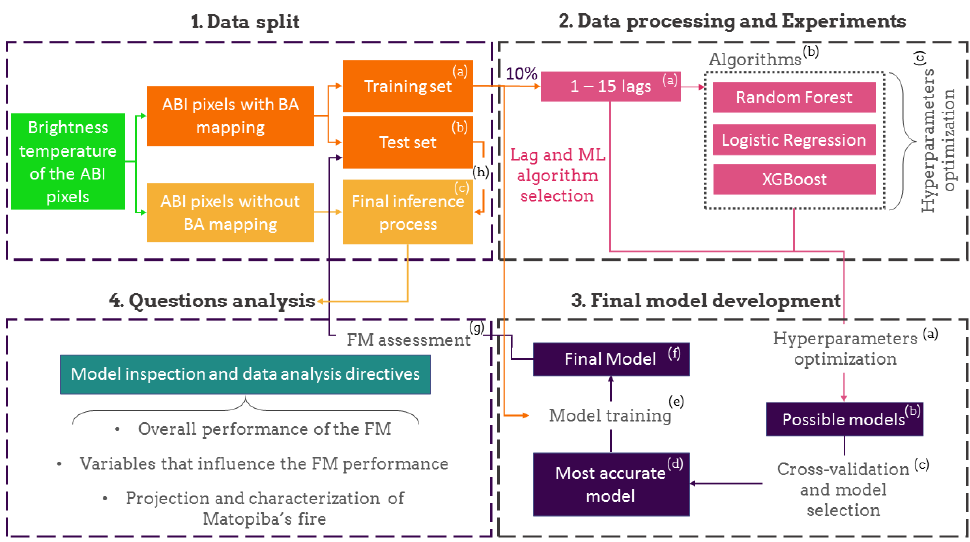
Figure 4. Methods divided into four main steps: data split, data processing and experiments, Final Model (FM) development and questions analysis. XGBoost: Extreme Gradient Boosting; ML: Machine